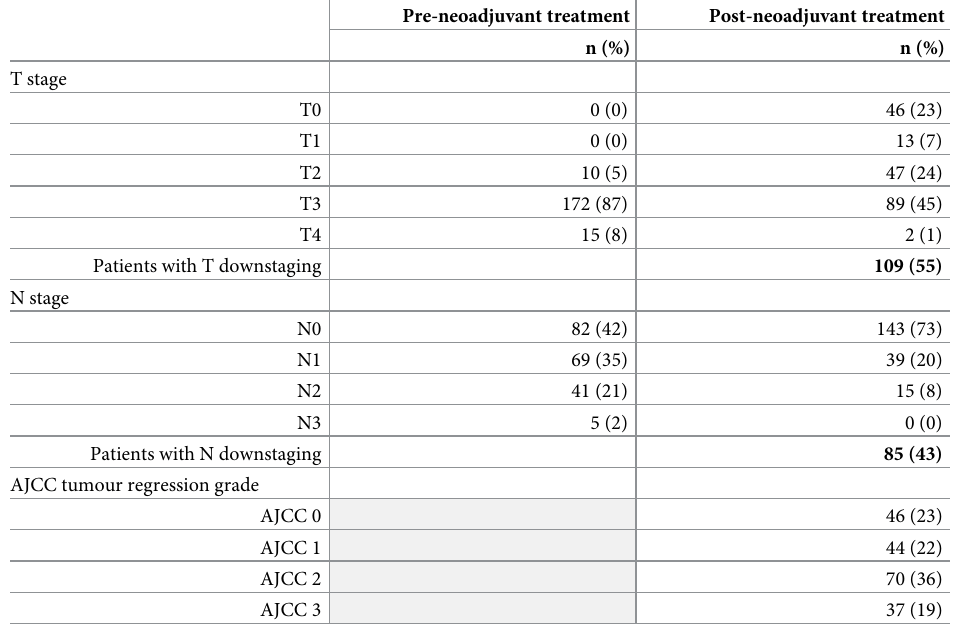
Table 2. Tumour downstaging in response to neoadjuvant treatment. Pre-neoadjuvant treatment Post-neoadjuvant treatment n (%) n